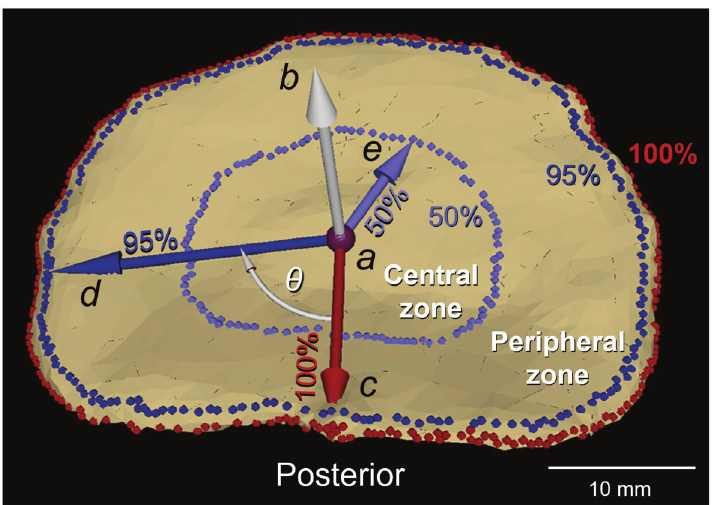
Fig 3. Determination of central and peripheral zones based on endplate-based spherical coordinate system. a : centroid of the endplate and origin of the endplate-based polar coordinate system used to define the endplate zones (0˚ coincides with posterior direction and positive angle values are clockwise). b : endplate normal vector. c : vector pointing towards the most posterior point of the endplate. (note: penetrating arrowhead demonstrates the 3D nature of the endplate surface) d : a vector with a length of 95% of the maximum radius. e : a vector with a length of 50% of the maximum radius. θ : angular parameter. Red dots : outermost margin. Dark blue dots : concentric margin contracted to 95% of the outer margin. Light blue dots; concentric margin contracted to 50% of the outer margin.